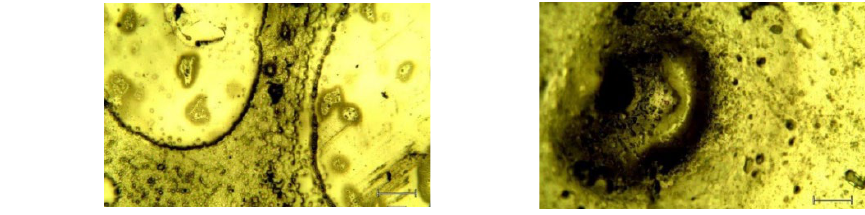
Figure 8. Light microscopic appearance of resin at different thicknesses after 31 days in sulphuric acid. The scale corresponds to 100 µm .